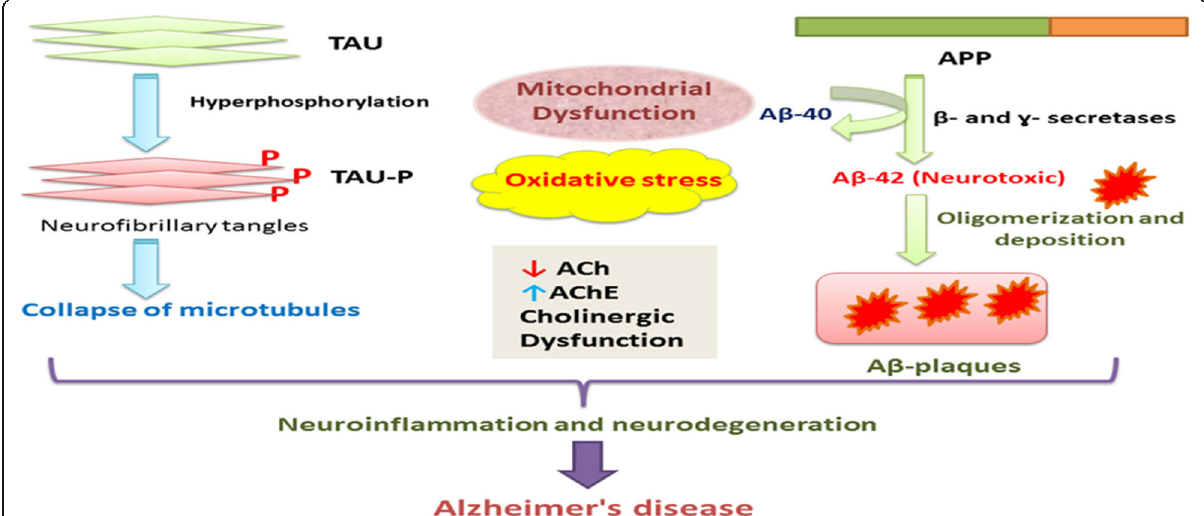
Fig. 2 Pathological events related to underlying AD neurodegeneration. These events include the amyloid deposition in the brain due to the uncontrolled cleavage of APP and the degeneration of neurotoxic A β -42 peptides, hyperphosporhylation of tau protein and the formation of intracellular neurofibrillary tangles, the deficiency of acetylcholine (ACh) due to its increased hydrolysis by acetylcholinesterase (AChE), oxidative stress, and mitochondrial